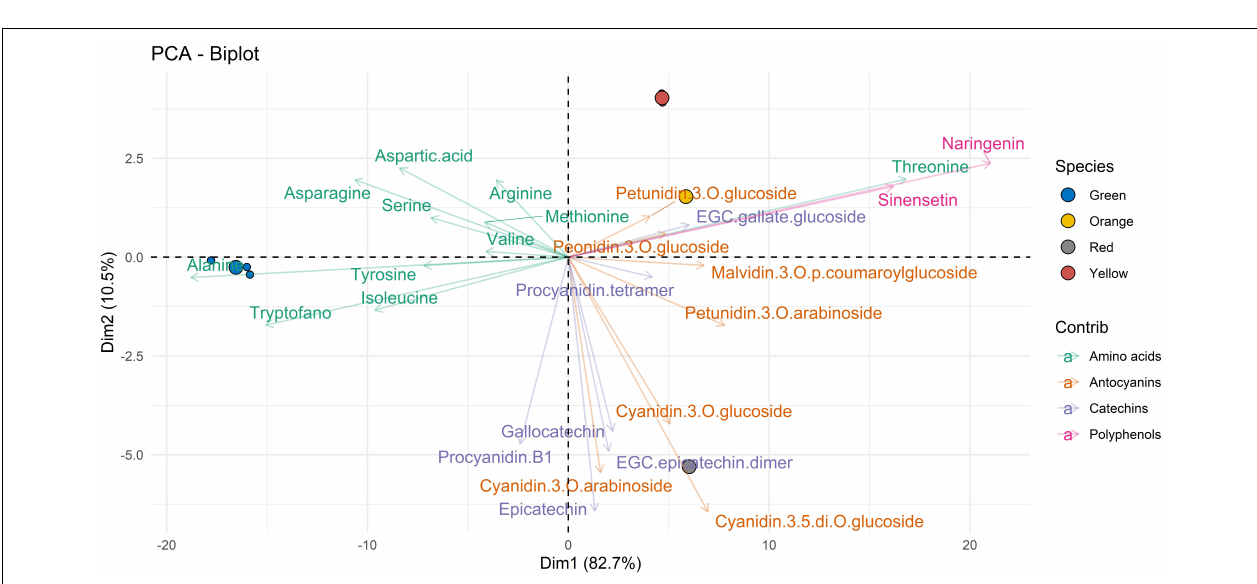
FIGURE 4 | Two-dimensional principal component analysis (PCA) biplot showing associations between experimental samples ( A. unedo fruit) and compounds abundance (clr-transformed data). Original data are summarized in Table 6 and in Supplementary Table 1 . Compounds extracted in E3 are represented. Samples are shown according to the ripening stages (green, yellow, orange, and red) and compounds are shown according to polyphenol categories.